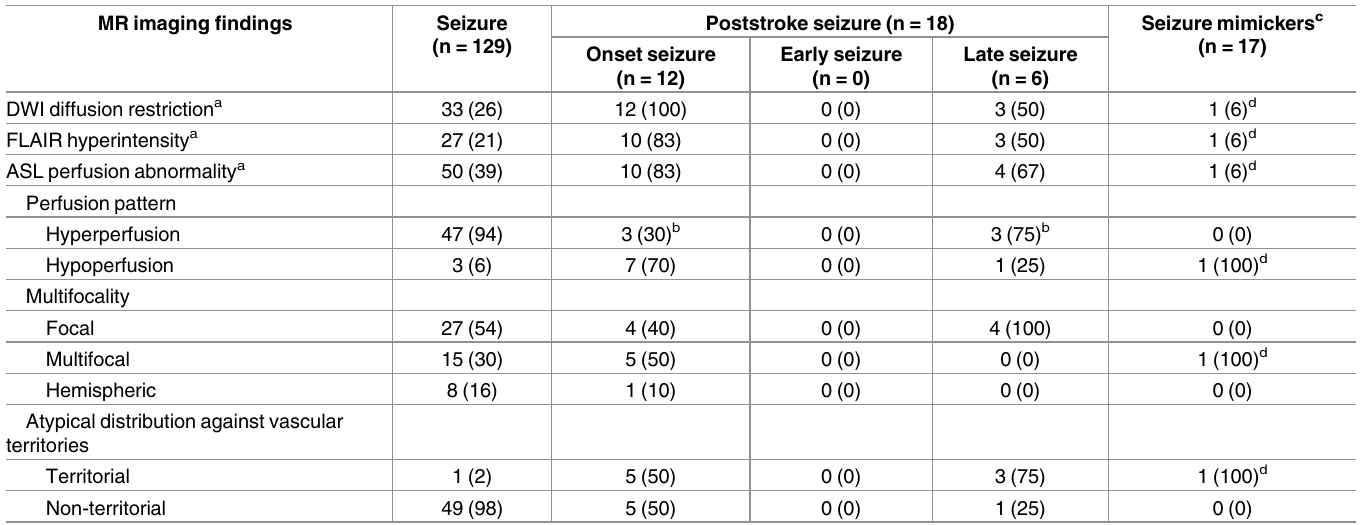
Table 1. Summaryof MR imaging findings according to final